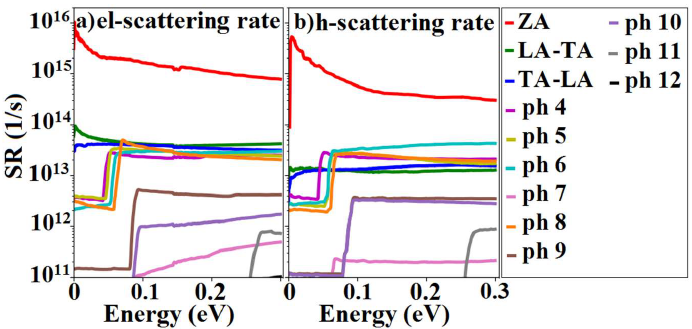
Figure 7. The scattering rates of ( a ) electrons and ( b ) holes in silicane which were calculated at room temperature with a cut-off wavelength of 16 nm. The zero-energy in electron/hole scattering rates shows conduction band minimum and valence band maximum. Note that the 12th phonon branch scattering rates for electrons and holes were less than 10 11 s − 1 and, thus, almost non-visible in these plots.